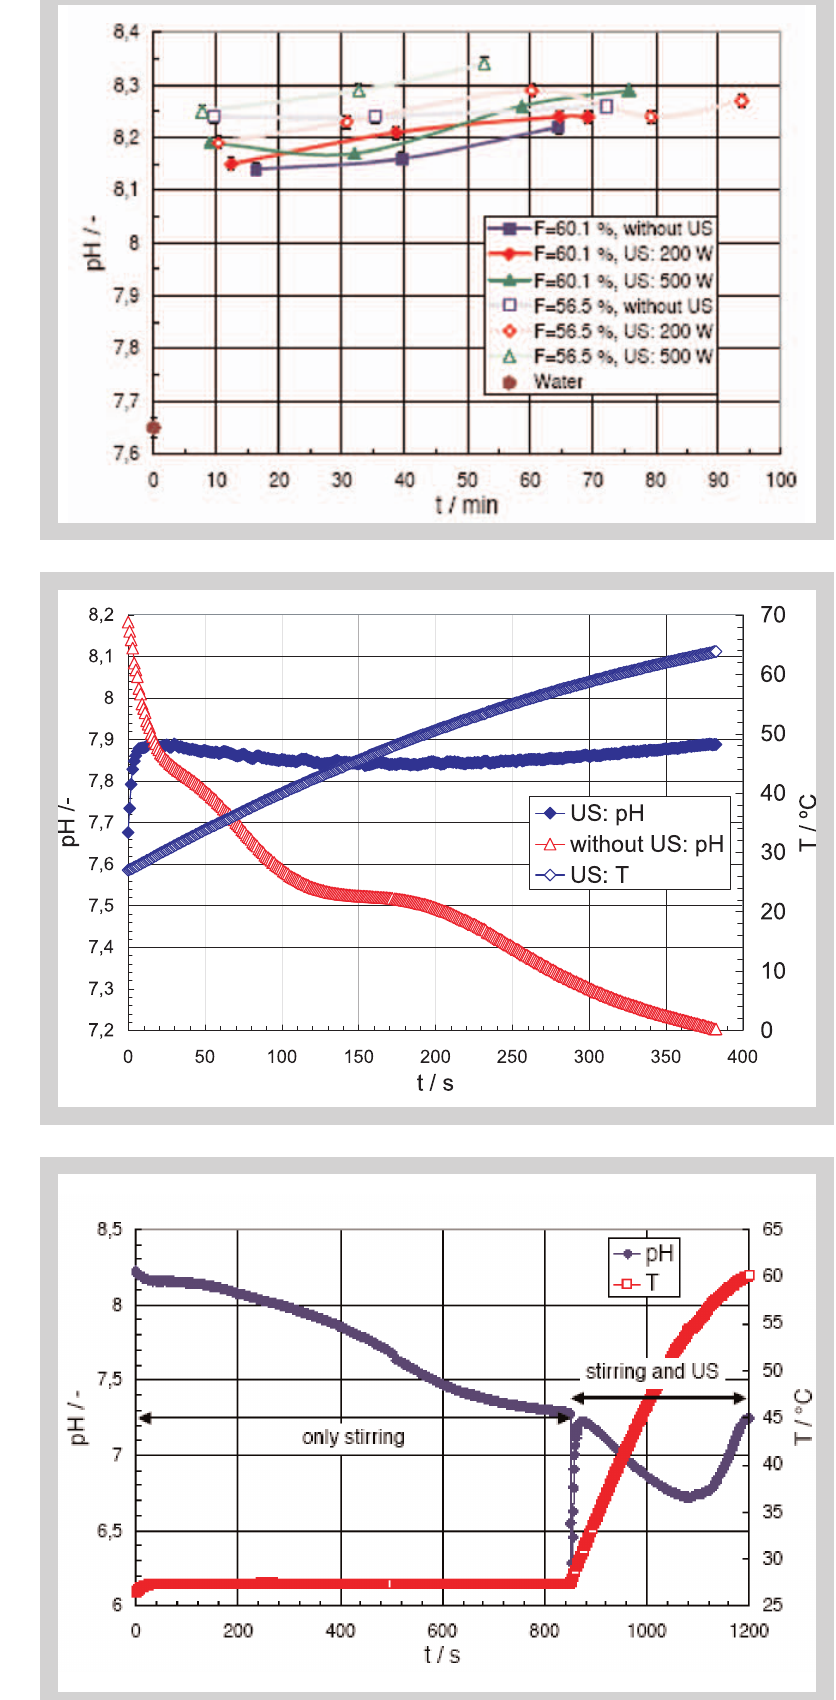
Figure 7 (from top to bottom): pH-value for (a) samples taken during the pumping and ultra- (V· sonic treatment = 4 l/min), (b) water stirred in a glass beaker with magnetic stirrer (200 rpm, P max = 500 W), (c) a suspension (F = 56.5 %, 160 g mixture, 200 rpm, P max = 500